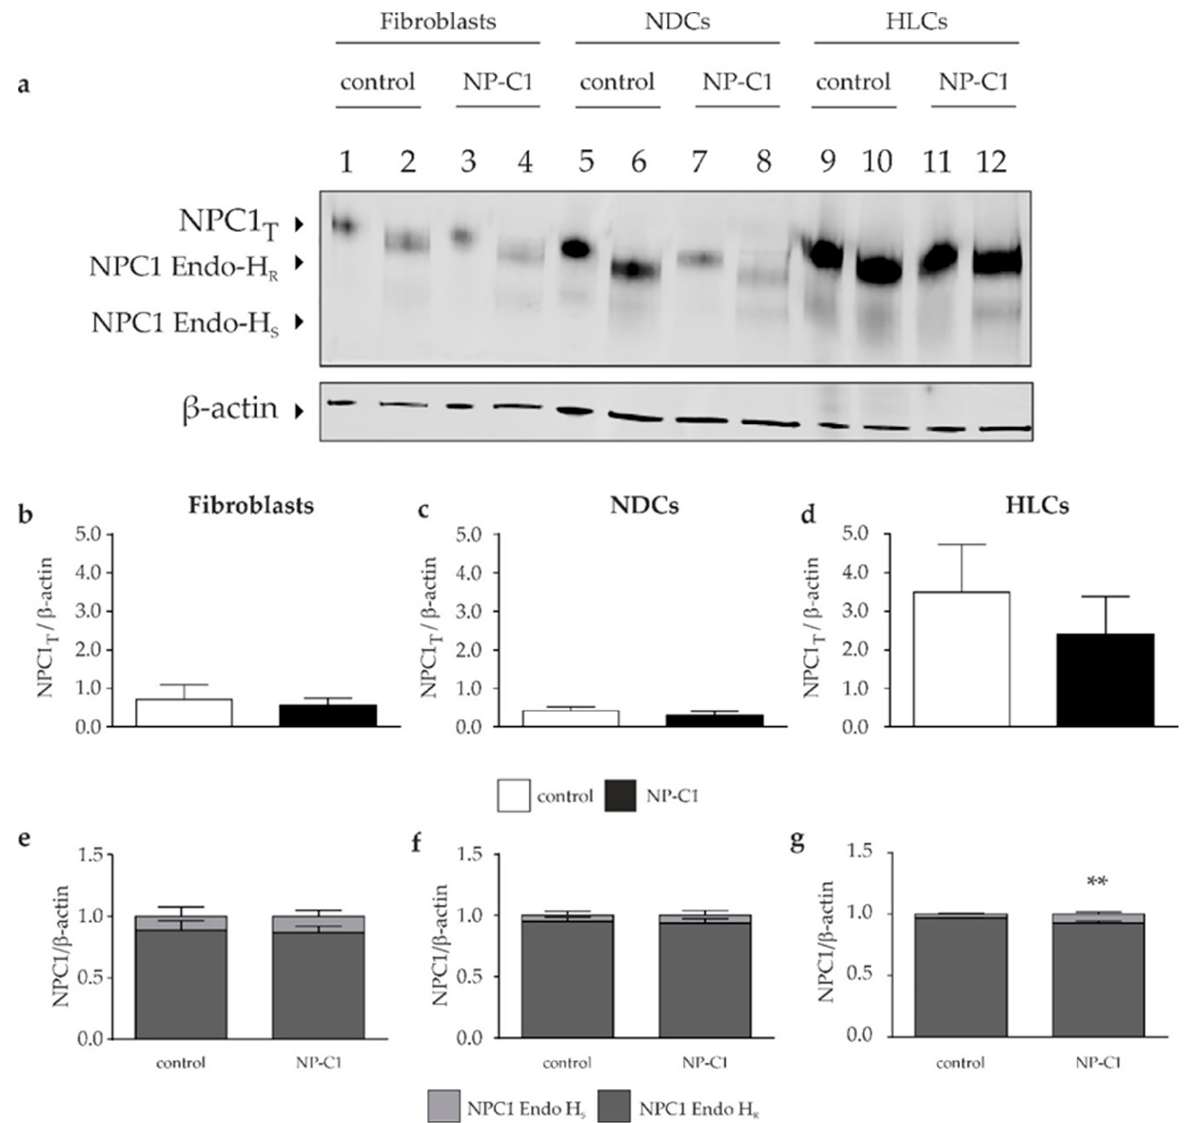
Figure 5. NPC1 protein level in fibroblasts, NDCs, and HLCs. ( a ) Western blot analysis was performed to determine the total NPC1 protein amount indicated by NPC1 T in lanes 1, 3, 5, 7, 9, and 11. Digestion of the samples with endoglycosidase H (Endo-H) was used to quantify the amount of Endo-H-resistant and Endo-H-sensitive amount of NPC1 protein (lane 2, 4, 6, 8, 10, and 12). ( b – d ) Quantification of the total NPC1 amount revealed comparable protein content in control and NP-C1 mutated cells, in the respective cell types. At the same time, the HLCs displayed more NPC1 protein than the fibroblasts or NDCs. ( e – g ) Irrespectively of the cell type, digestion of the samples with endoglycosidase H revealed comparable high amounts of Endo-H-resistant NPC1 protein portion. ** = p <